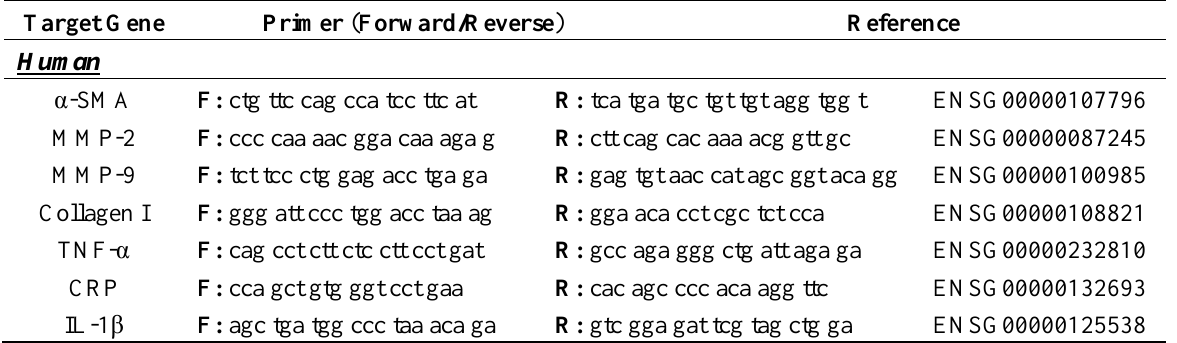
Table 3. List of the sets of probes and primers (Roche Diagnostics) for specific genes, used in quantitative real-time